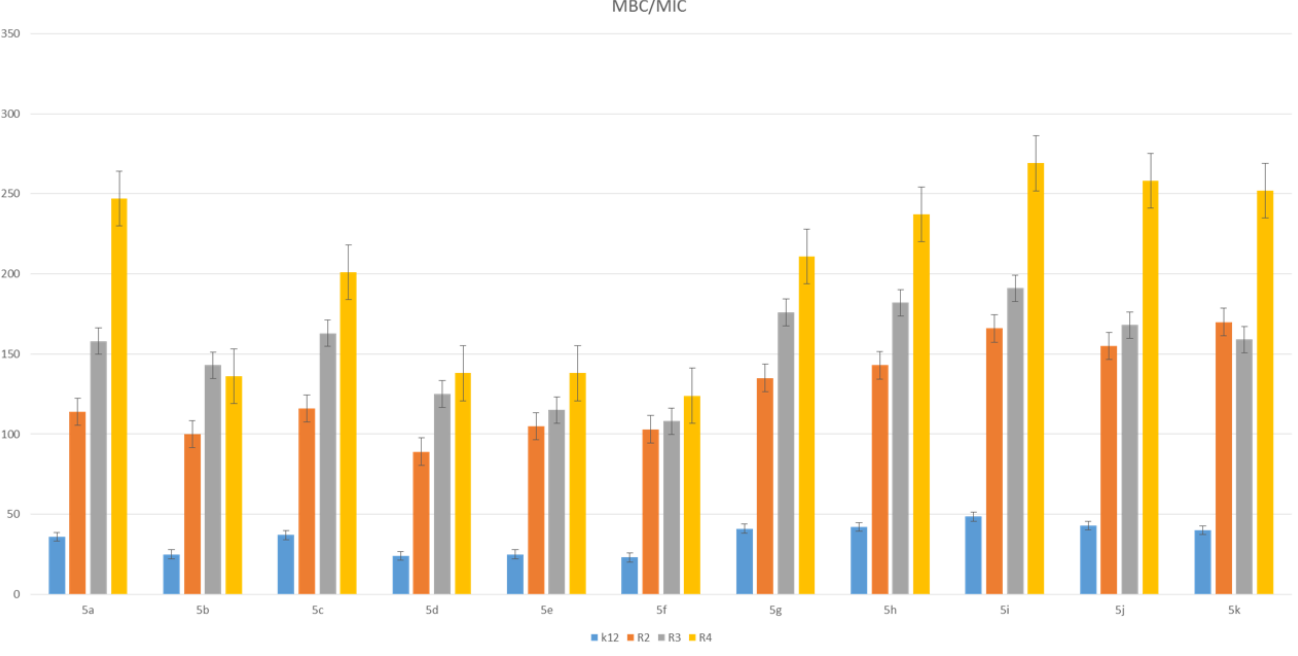
Figure 5. MBC/MIC of the pyridine derivatives in model bacterial strains. The x -axis compounds 1 – 11 were used sequentially. The y -axis shows the MBC/MIC value in µg /mL −1.